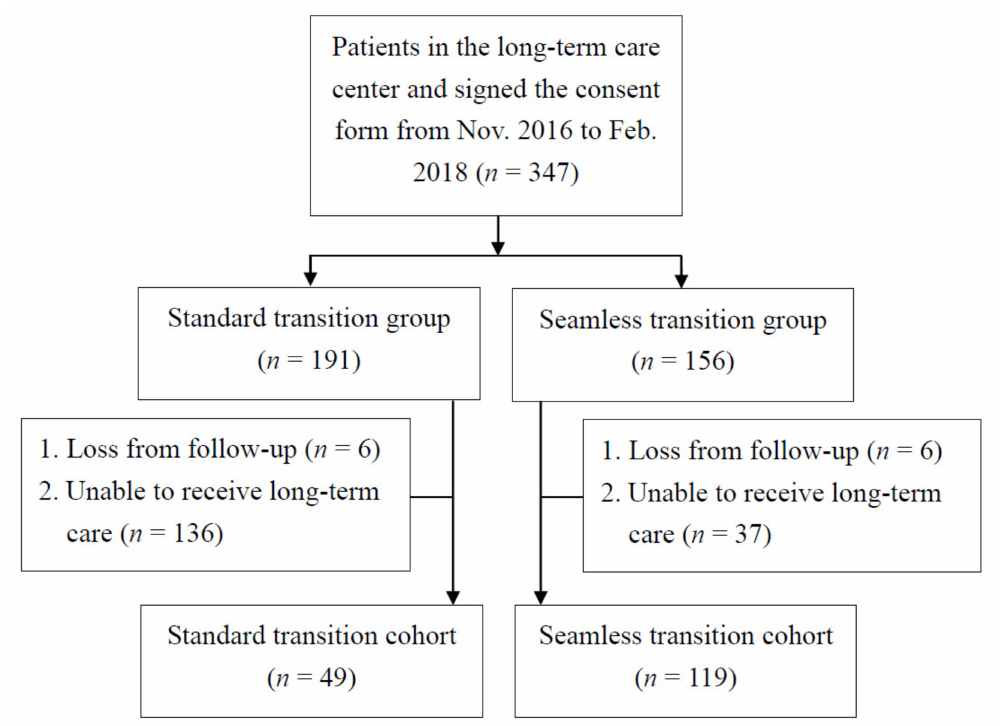
Figure 1. Flowchart of sample selection